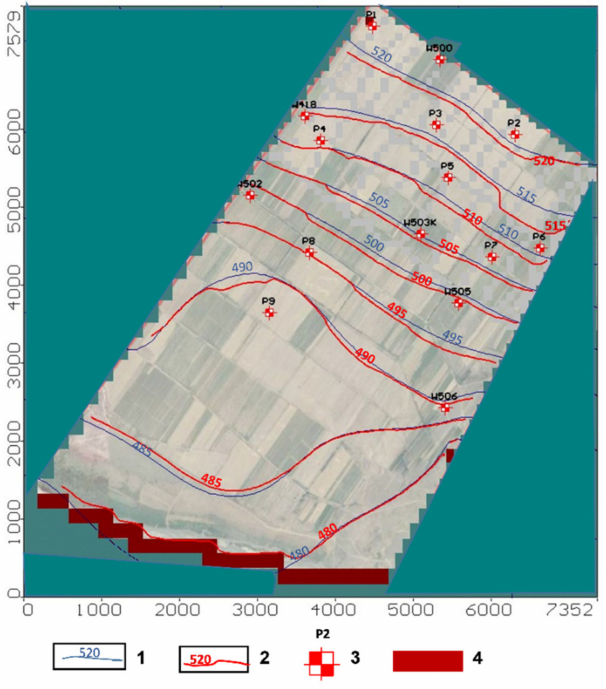
Figure 5. Comparison of the initial groundwater head and the model-calculated ones. Results of the steady-state simulation: 1—initial groundwater head; 2—model-calculated groundwater head; 3—observation well; 4—Kapshagai reservoir (first-type boundary